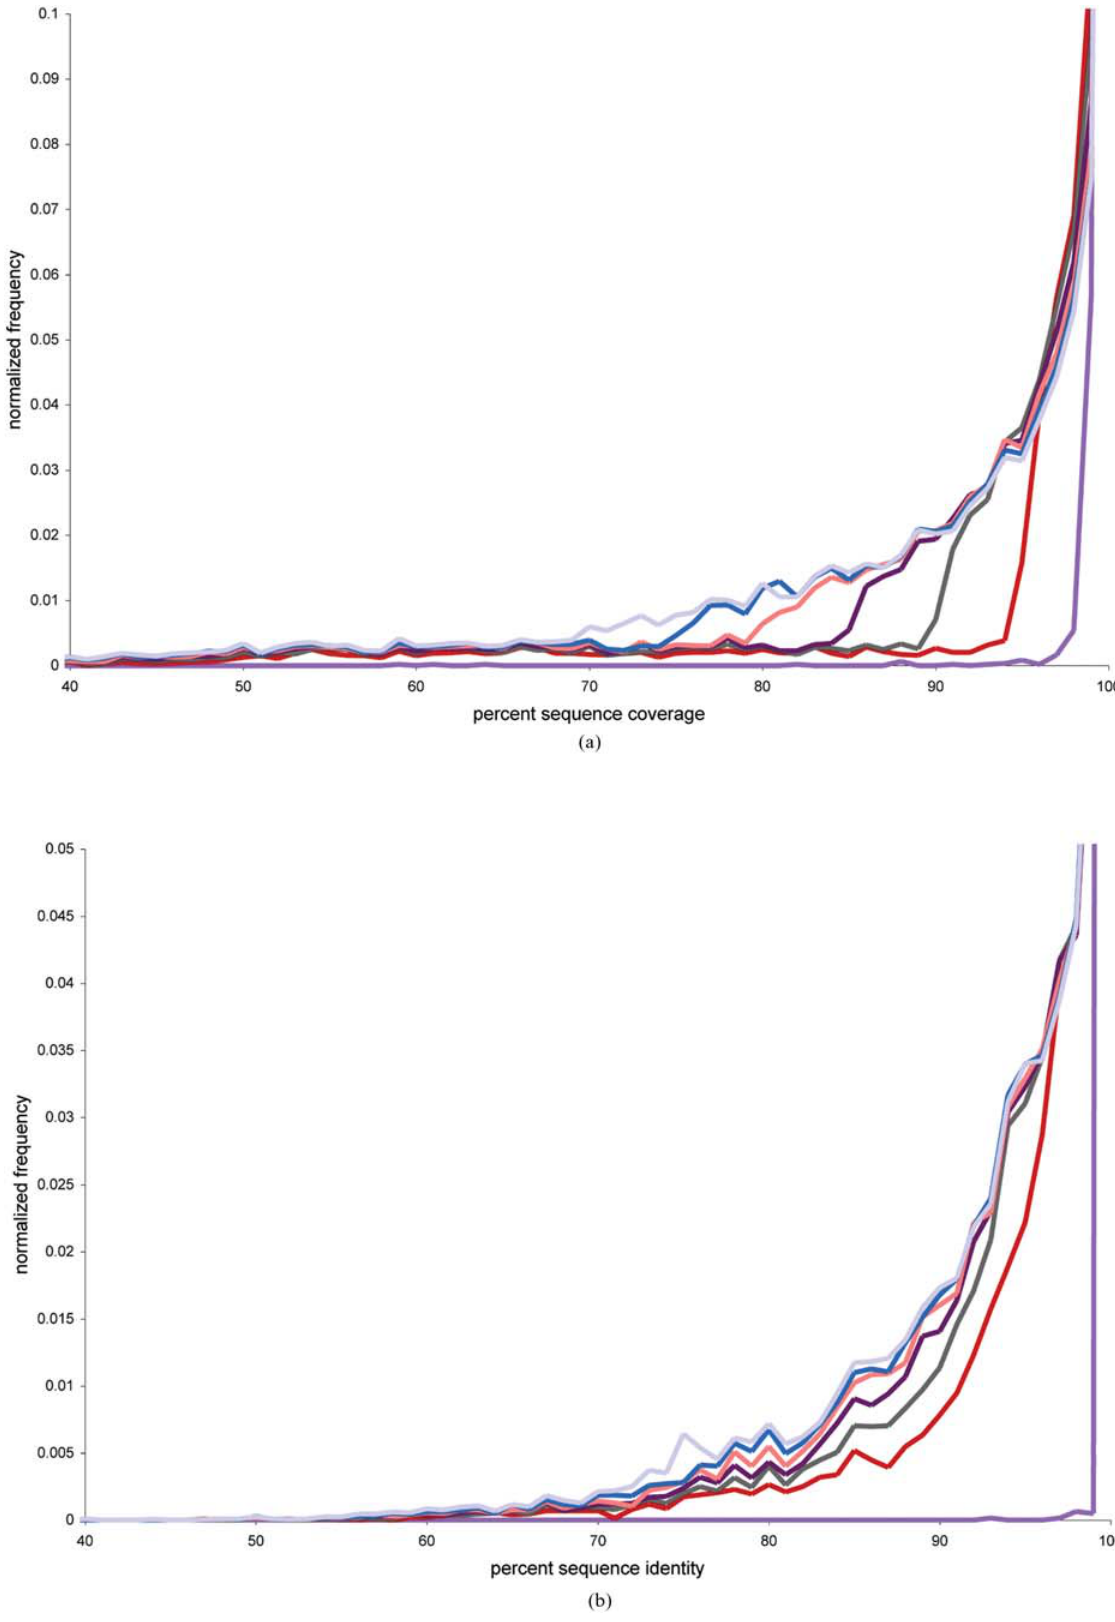
Figure 3. a . Histogram of distribution of pairwise sequence coverages within gene prediction clusters. Different curves refer to different sequence identity thresholds used for clustering. Color purple, red, brown, dark purple, pink, blue, cyan corresponds to cutoff values of 100%, 95%, 90%, 85%, 80%, 75%, 70%, respectively. b . Histogram of distribution of pairwise sequence identities within gene prediction clusters. Different curves refer to different sequence identity thresholds used for clustering. Color purple, red, brown, dark purple, pink, blue, cyan corresponds to cutoff values of 100%, 95%, 90%, 85%, 80%, 75%, 70%, respectively. doi:10.1371/journal.pone.0003899.g003 PLoS ONE |